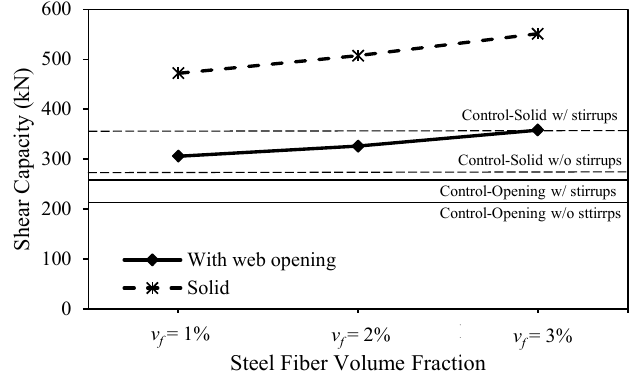
Figure 22. Shear load–deflection responses: ( a ) solid models; ( b ) models with web openings.